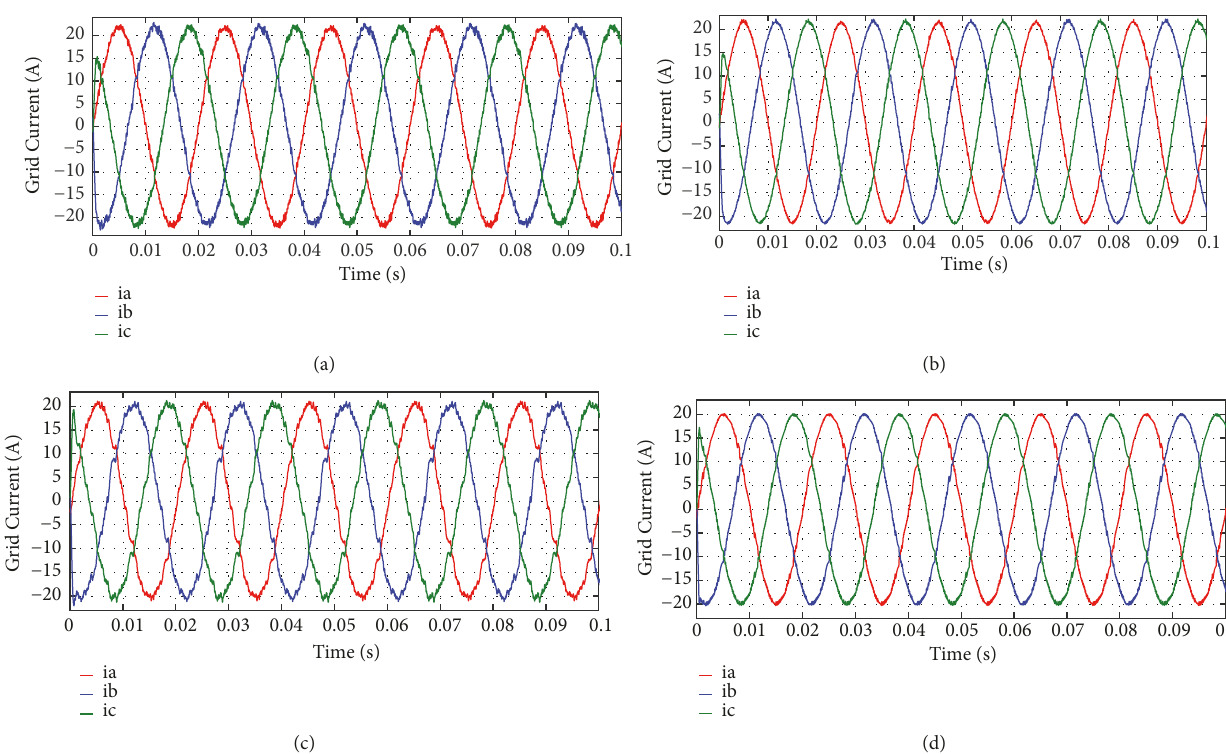
Figure 6: Simulation waveform of three phase grid current at 50 𝜇 s sampling time for (a) the conventional MPVC, (b) the proposed MPVC, (c) the conventional MPCC, and (d) the proposed MPCC.